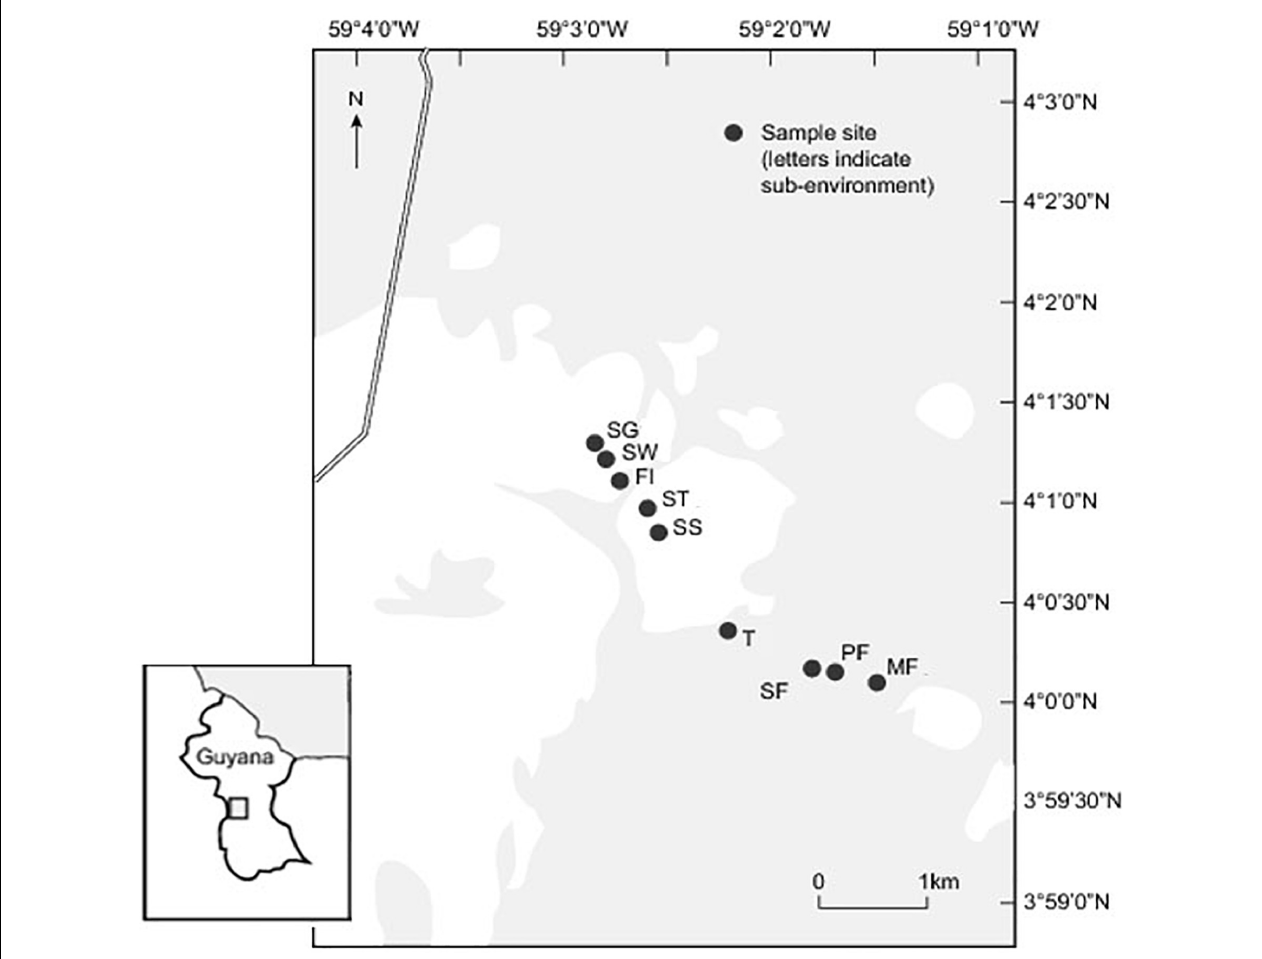
FIGURE 1 | Location of study sites in Wowetta, Central Guyana. White areas indicate the Northern Rupununi savannah and green areas indicate rainforest. SG, Savannah Grassland; SW, Savannah Woodland; FI, Forest Island; ST, Savannah Tree; SS, Savannah Swamp; T, Transition zone; SF, Swamp Forest; PF, Pisoplinthic Forest; MF, Mixed Forest. Inset: the location of the study areas within